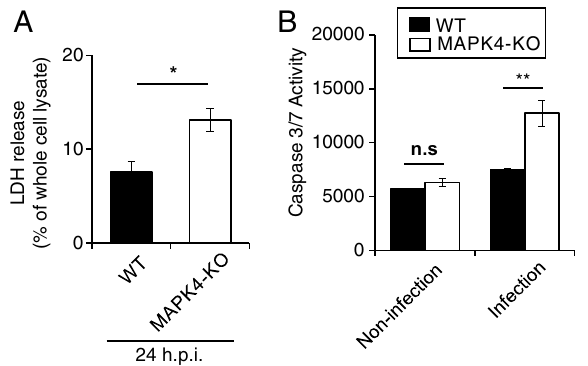
Figure 3. Increased host cell death and caspase 3/7 mediated-apoptotic cell death in C. parvum- infected MAPK4-KO HCT-8 cells. ( A ) LDH-based mortality of C. parvum -infected WT and MAPK4-KO HCT-8 cells at 24 h post-infection. Percentages represent the ratio of LDH release to whole cell lysates. * p < 0.05 (Student’s t test). ( B ) Apo-ONE homogeneous caspase 3/7 activity in C. parvum -infected WT and MAPK4-KO HCT-8